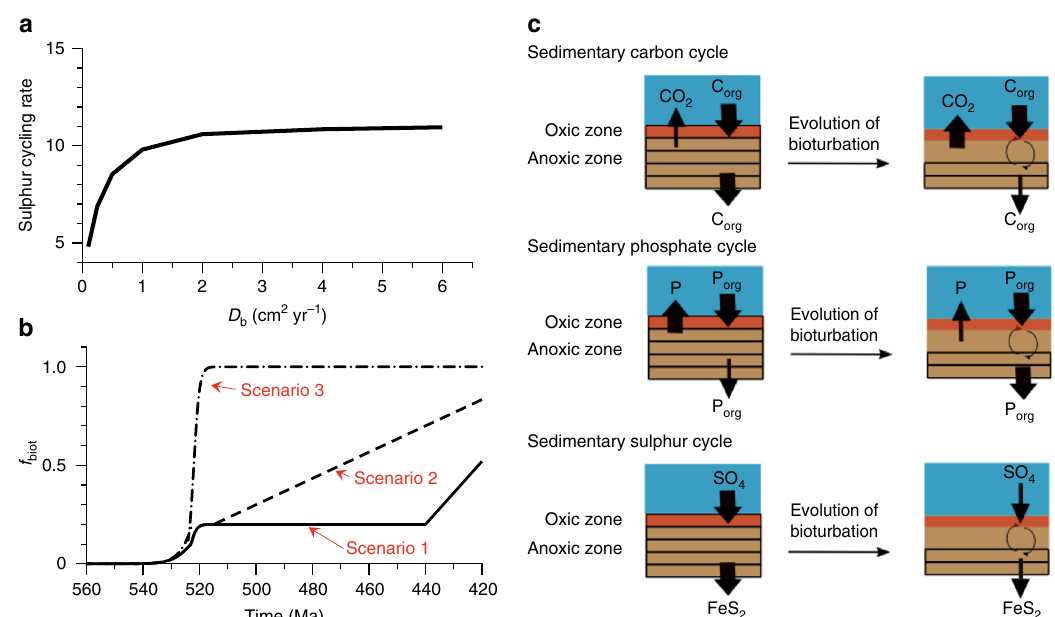
Fig. 4 The effect of bioturbation on sediment geochemistry. a The effect of bioturbation intensity ( D b ) on the sulphur cycling rate. Model results reproduced from ref. 16 . b Solid line (Scenario 1): the bioturbation impact on geochemistry ( f biot ) is linearly correlated with the depth and intensity of burrowing. Dashed line (Scenario 2): the bioturbation impact is maximal with shallow burrowing, but the areal expansion of bioturbation increases gradually throughout the early Palaeozoic. Dash-dotted line (Scenario 3): the bioturbation impact on geochemistry ( f biot ) is already at full strength by the end of the Cambrian explosion. c Simpli fi ed conceptual model of the effect of bioturbation on the sedimentary cycles of carbon, phosphorus and sulphur. Arrow sizes denote relative changes in fl ux